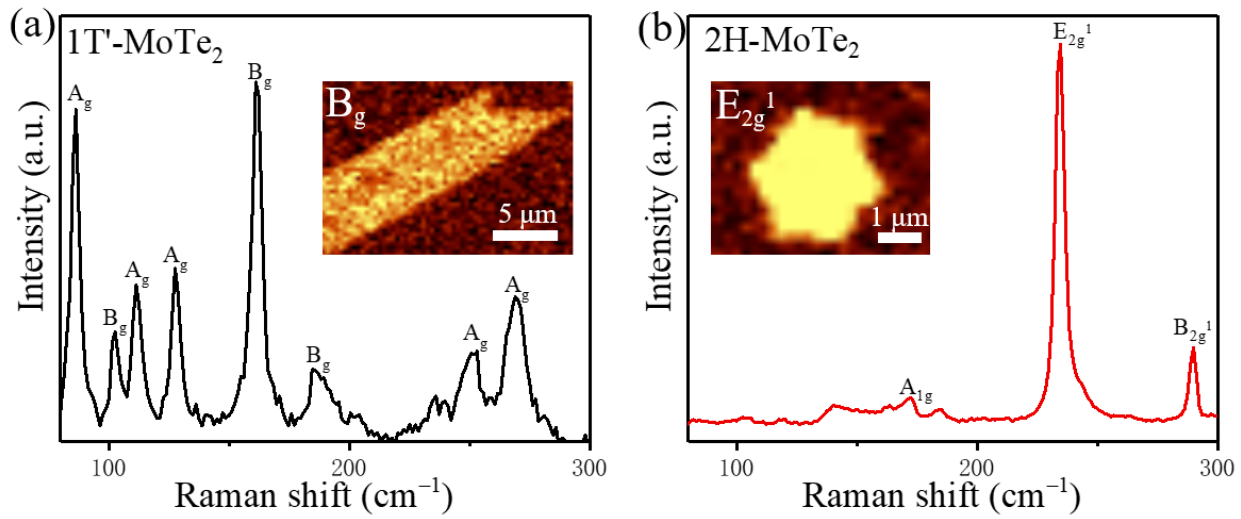
Figure 2. ( a , b ) Raman spectra of as-grown atomically thin 1T’-MoTe 2 and 2H-MoTe 2 , respectively. The inset in ( a ) shows its Raman mapping of the B g mode for 1T’-MoTe 2 . The inset in ( b ) shows Raman mapping of the E 2g 1 mode for 2H-MoTe 2 .